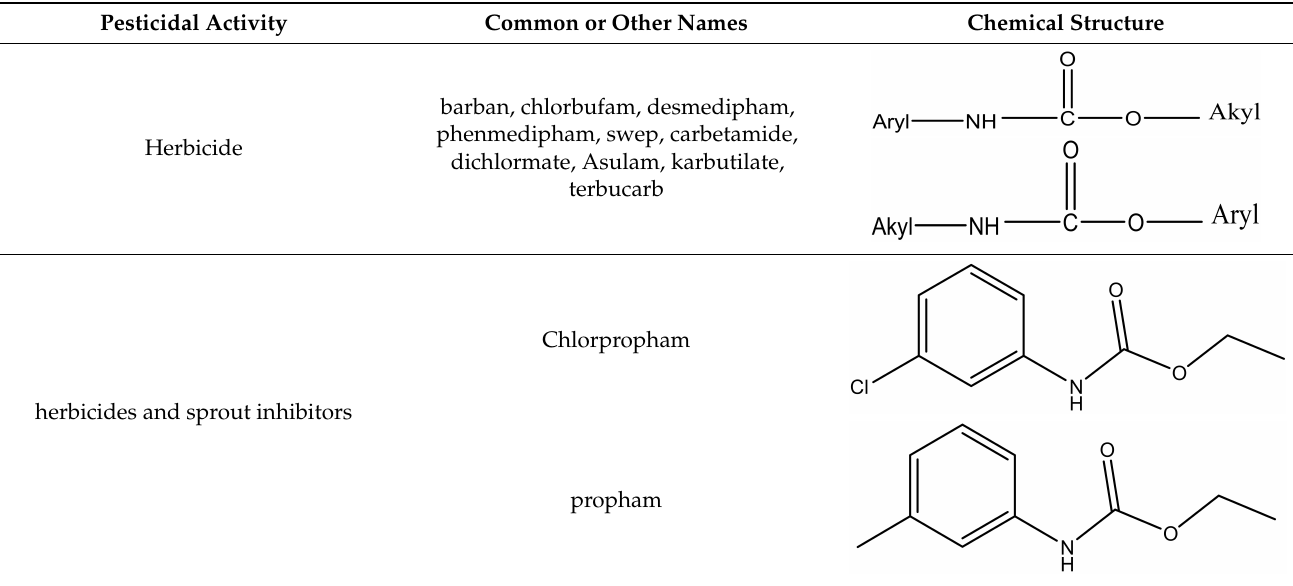
Table 5. Relationship between pesticidal activity and chemical structure of CMs